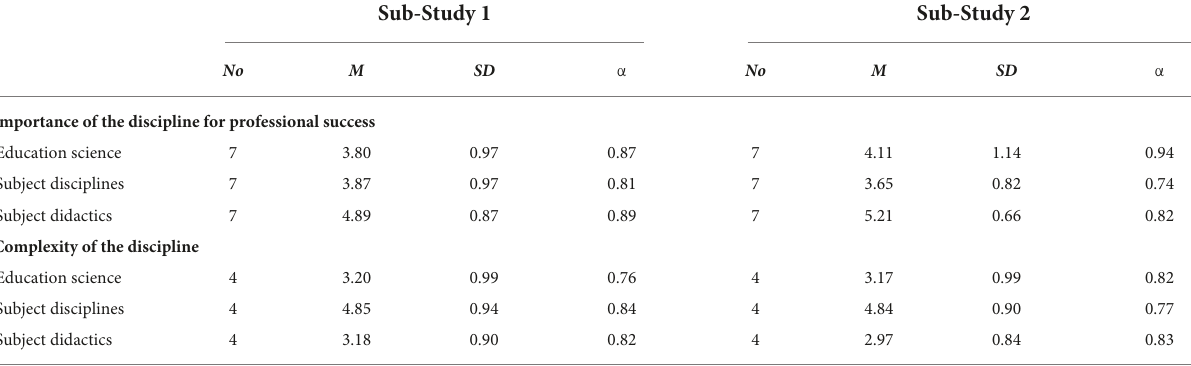
TABLE 2 Descriptive statics for the instruments measuring student teachers’ beliefs about the three disciplines (Sub-Study 1 and Sub-Study 2).